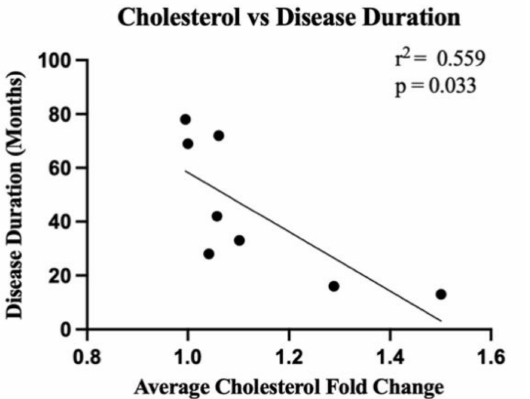
Figure 5. There is a significant correlation between cholesterol levels in the white matter of the motor cortex in ALS cases and disease duration. Linear regression analyses highlight the correlation (r 2 = 0.559) between the average of all cholesterol lipid species in ALS cases (sALS n = 8; expressed as a fold change from the average of all controls (n = 8)) and disease duration (months) ( p =